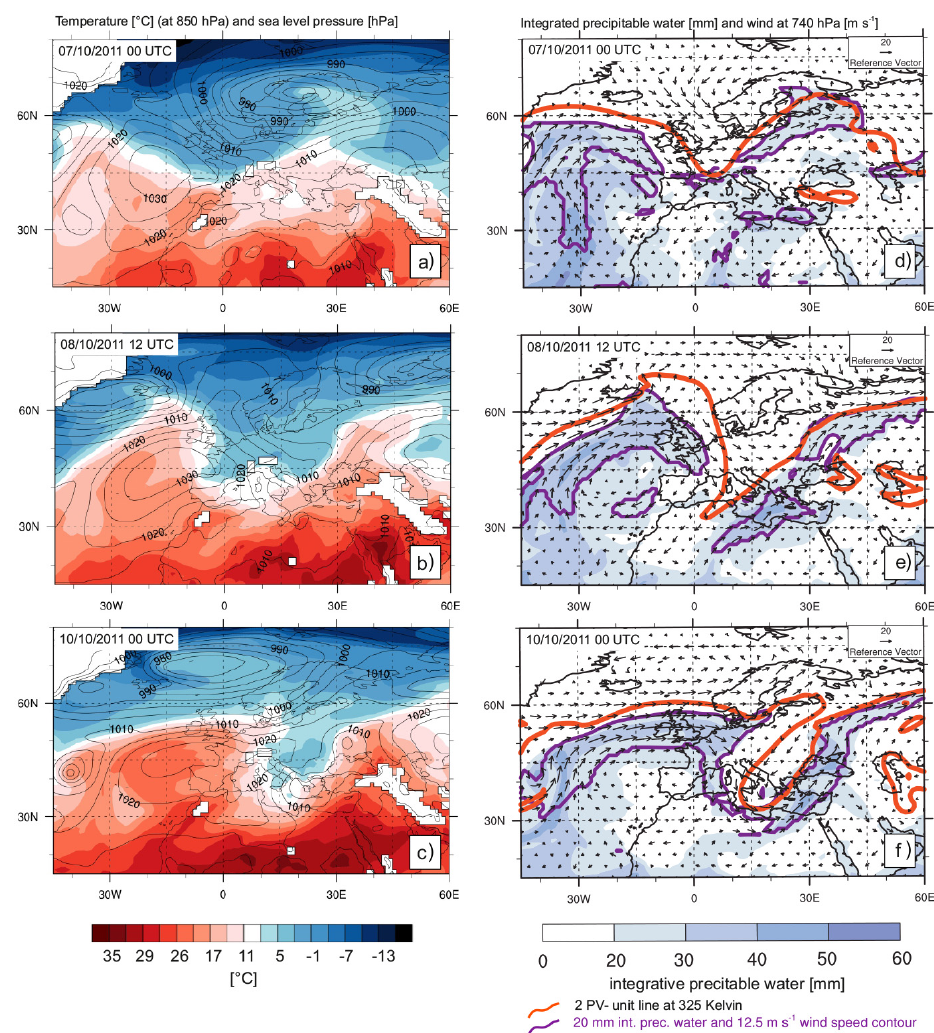
Figure 2. ECMWF reanalysis data on 7 October 2011 00:00UTC (top row), 8 October 2011 12:00UTC (middle row), and 10 October 2011 00:00UTC (bottom row). The left column (a–c) displays temperature in degrees Celsius at 850hPa (color) together with sea level pressure in hectopascal (contours). The right column (d–f) shows the vertically integrated precipitable water of the atmosphere in millimeters (color) together with the 740hPa wind in meters per second (arrows). The red line in the right column refers to the potential vorticity (PV) and illustrates the 2 PV unit limit on the 320 K isentrope. Violet lines in (d–f) indicate the outline of atmospheric river conditions, based on the definition by Ralph and Dettinger